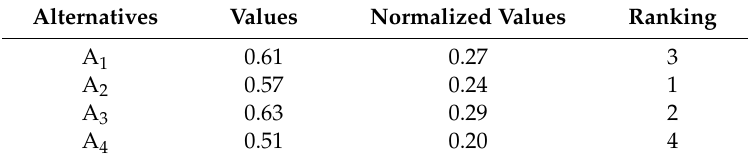
Figure 10. Final ranking using the various applied methods. Figure 11. Final ranking using the various applied methods. Table 27. The normalized weighted values of judgments matrix using the MOORA. Table 27. The normalized weighted values of judgments matrix using the MOORA.